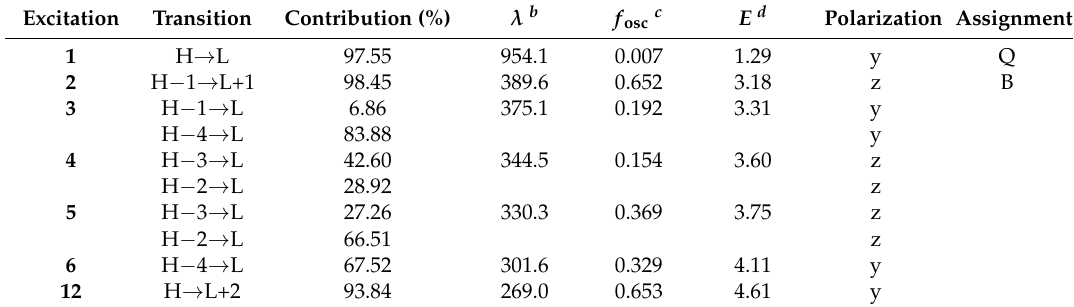
Table 4. Properties of the main electronic transitions of neutral unsubstituted (20)orangarin ( 20O ) a .